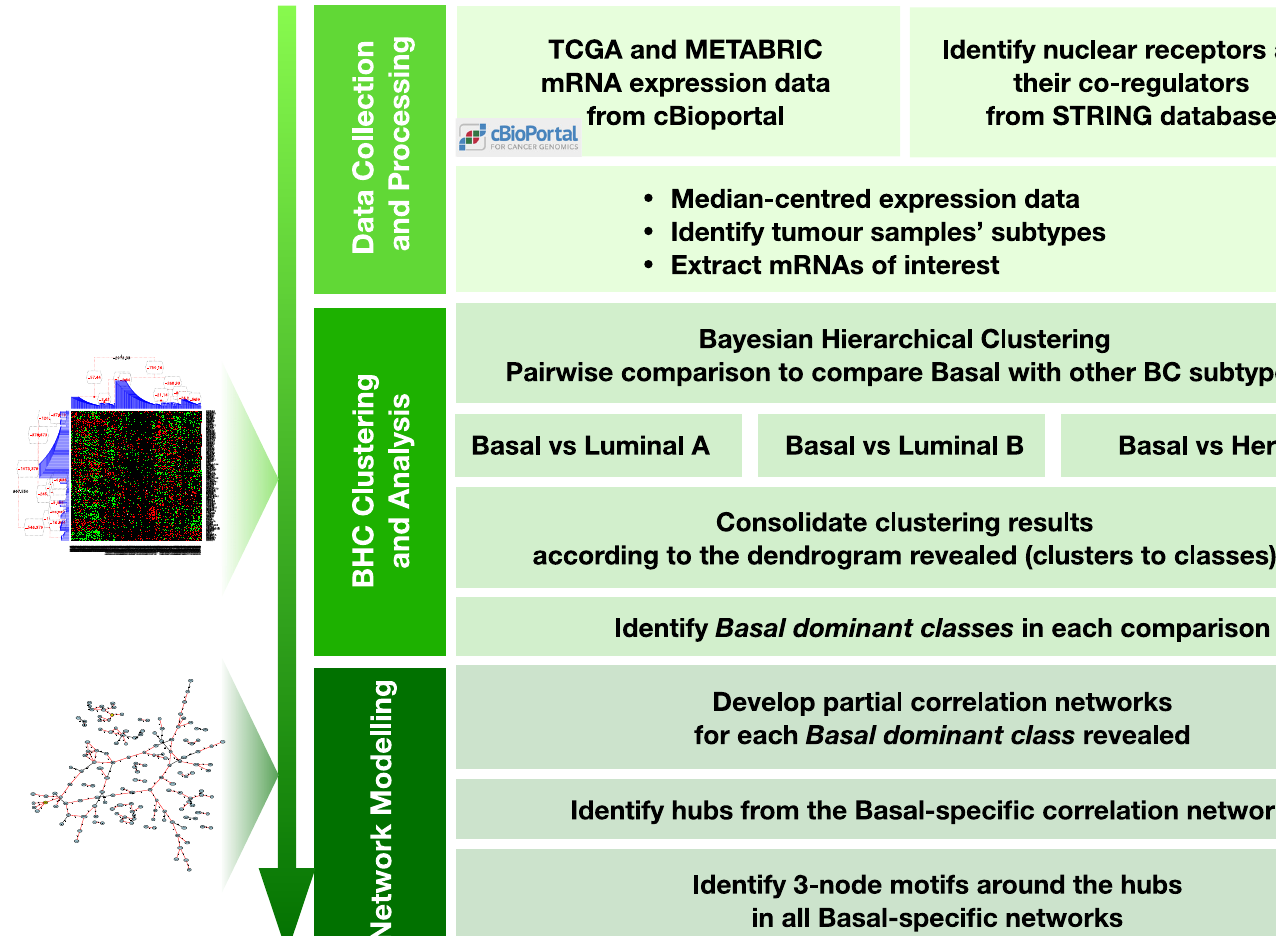
Fig 1. Overview of our approach for revealing critical modules in Basal-specific networks. Our method has three main steps, including (a) data collection and preparation, (b) breast cancer stratification from unsupervised clustering and (c) network modelling and analysis. Pictures on the left show a typical outcome from each step.